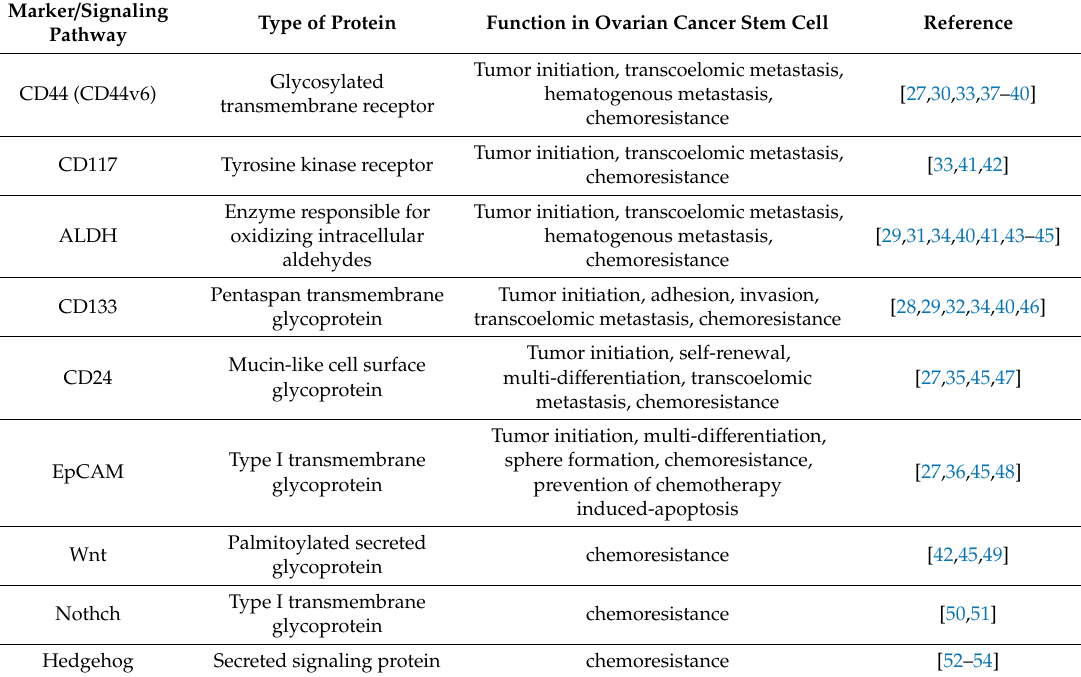
Table 1. Ovarian cancer stem cell markers and stem cell signaling